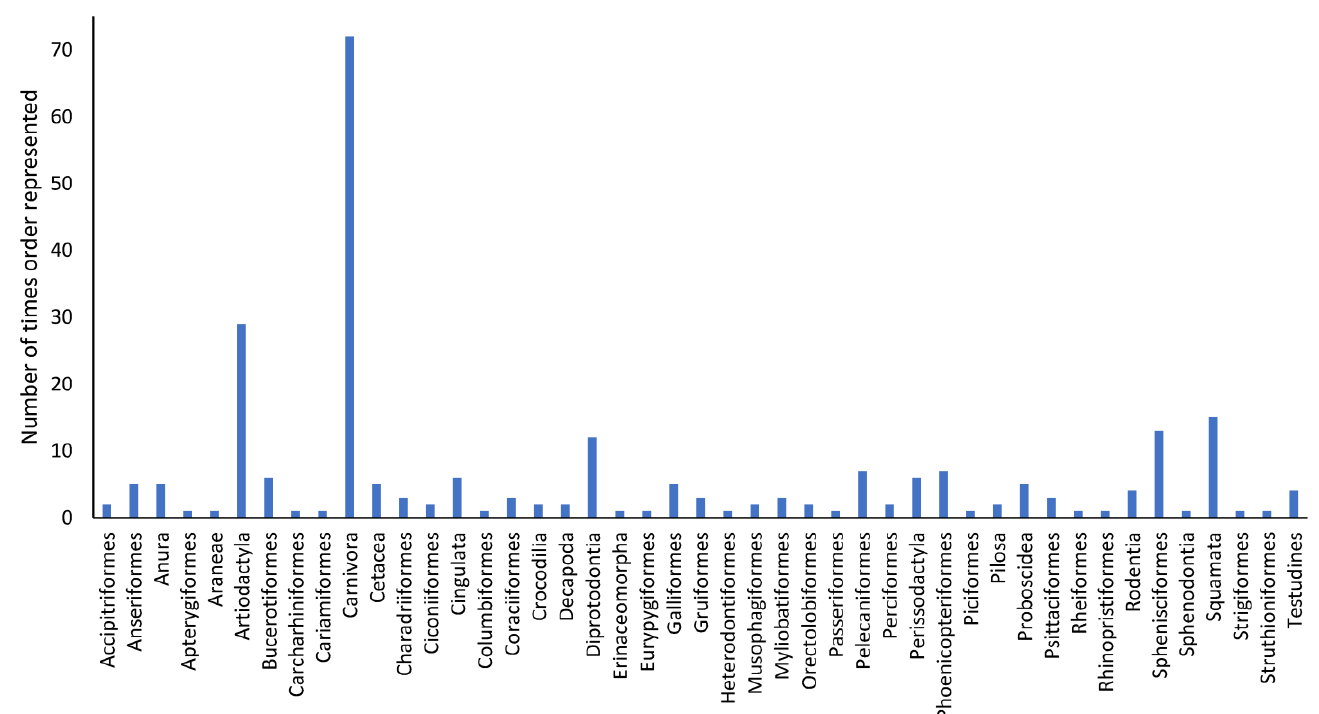
Figure 4. An overview of the orders represented in papers published on the visitor effect on zoo animals from 1992 to 2022.